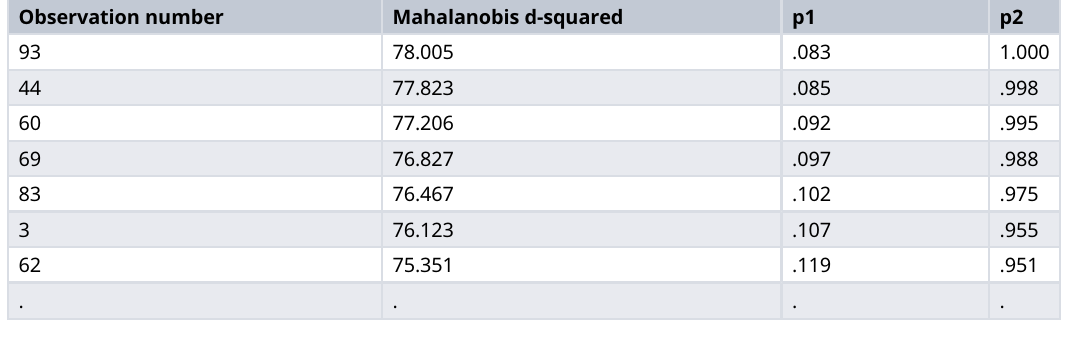
Table 1. Observations farthest from the centroid (Mahalanobis distance). Observation number